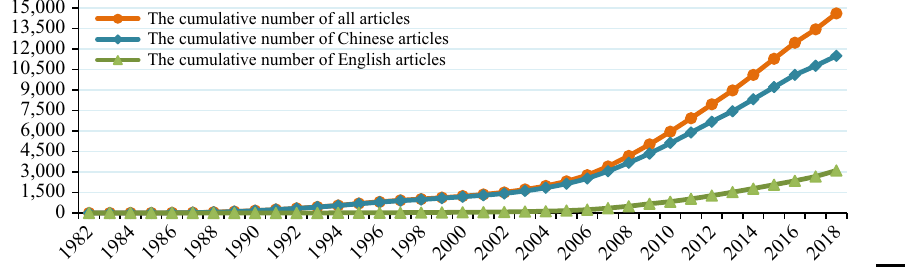
Figure 1. The cumulative number of articles year by